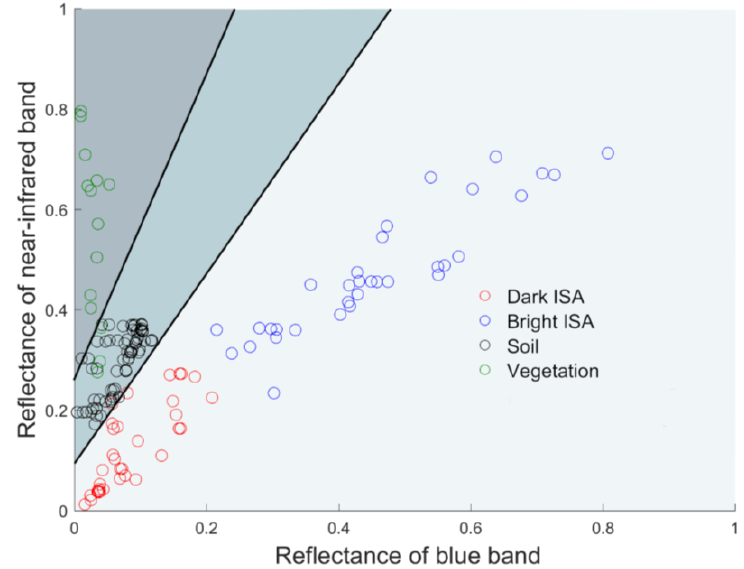
Figure 3. Scatter plot of selected samples in the blue–NIR feature space.